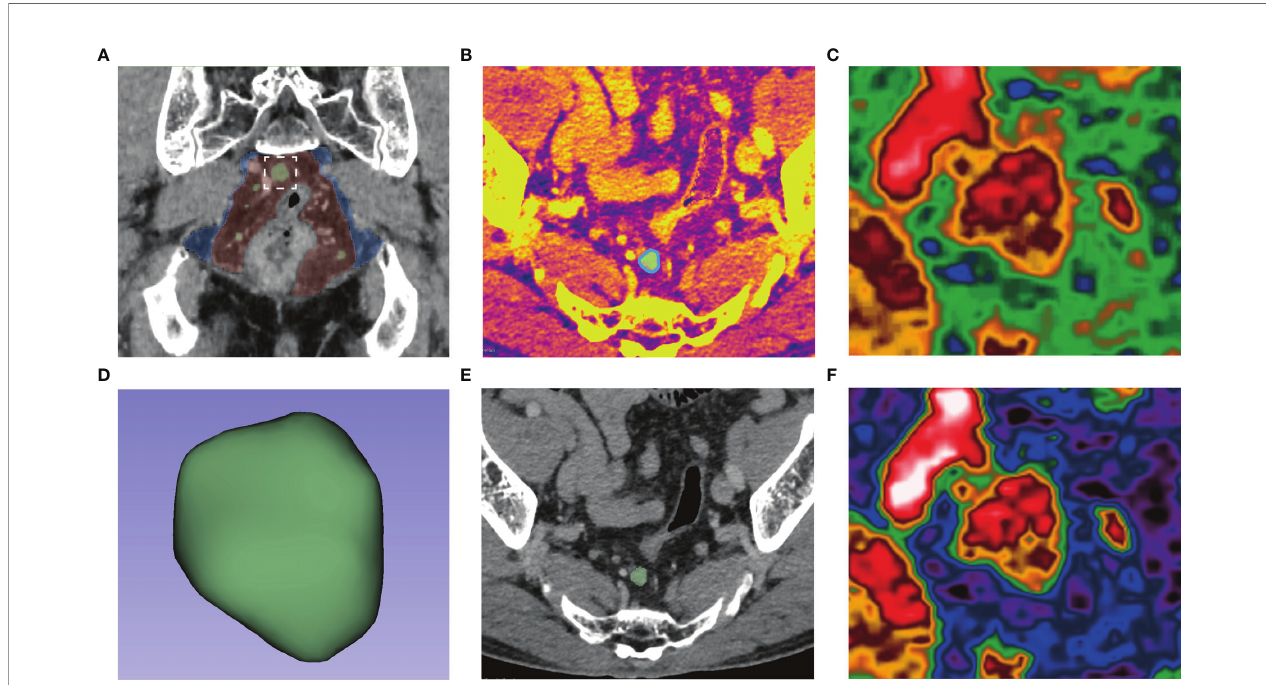
FIGURE 2 | (A) After searching for lymph nodes in the mesorectum (red) and extramesenteric (blue) areas, the largest lymph nodes (white box) were delineated along its edge (blue line) in the axial iodine map (B) to form a 3D-ROI (D) . The ROI could be used for 120kVp-like images without registration (E) . The pseudocolor map of the largest lymph nodes in the iodine map (C) and 120kVp-like image (F) show apparent internal